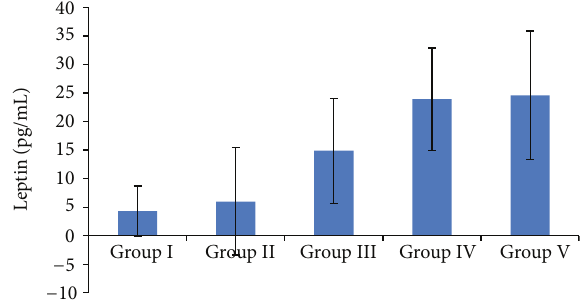
Figure 5: Serum leptin levels in relation to BMIs. Group I: low- weight; Group II: normal-weight; Group III: overweight; Group IV: obese;GroupV:morbidlyobese. 𝑃 < 0.005 forGroupIversusGroup II versus Group III versus Group IV and Group